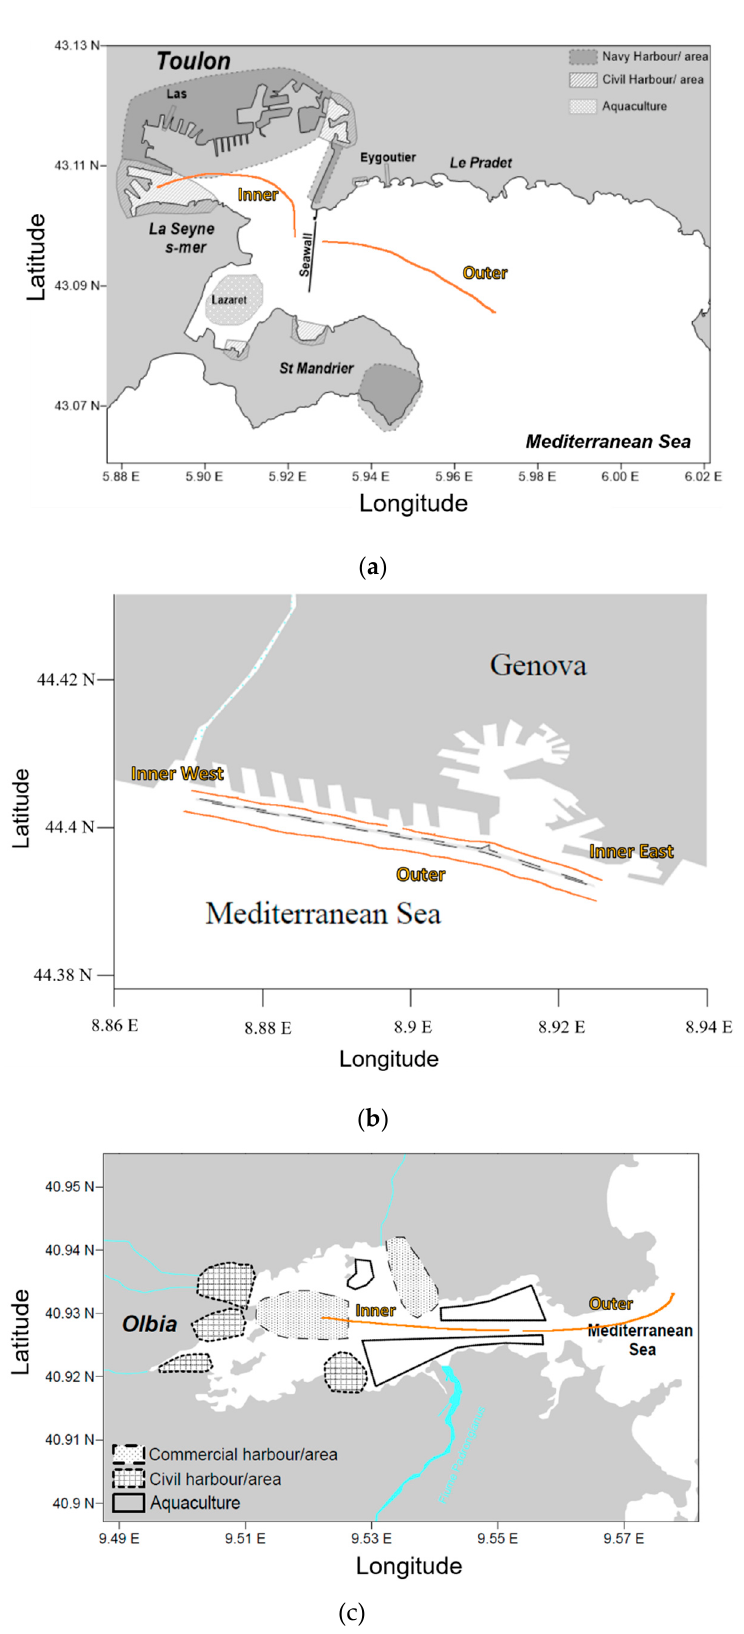
Figure 1. Sampling locations ( a ) Toulon, ( b ) Genova and ( c ) Olbia, with orange lines representing the performed transects.